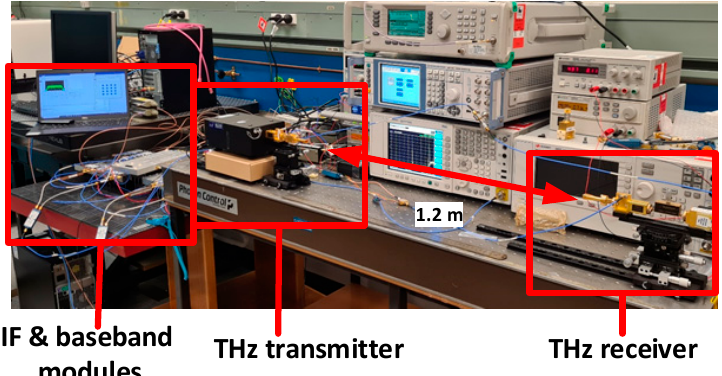
Figure 9. Photograph of the 30 Gbps THz communication demonstration platform.